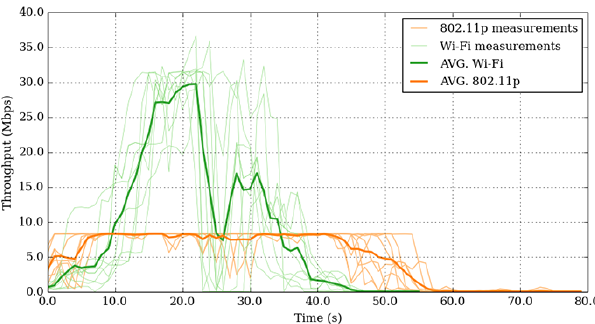
Figure 9. Data throughput from combined RWS–RSU to vehicle with 80kmh − 1 speed.